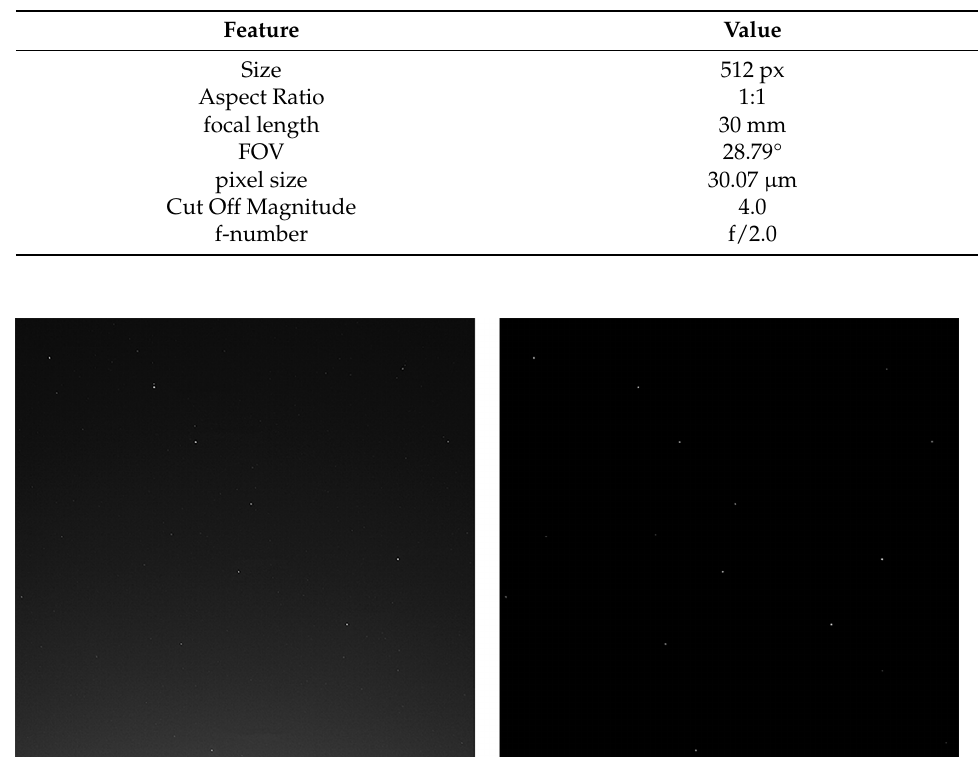
Table 2. Nikon D 3100 camera features. The image has been resized to 512 px and 1:1 aspect ratio.